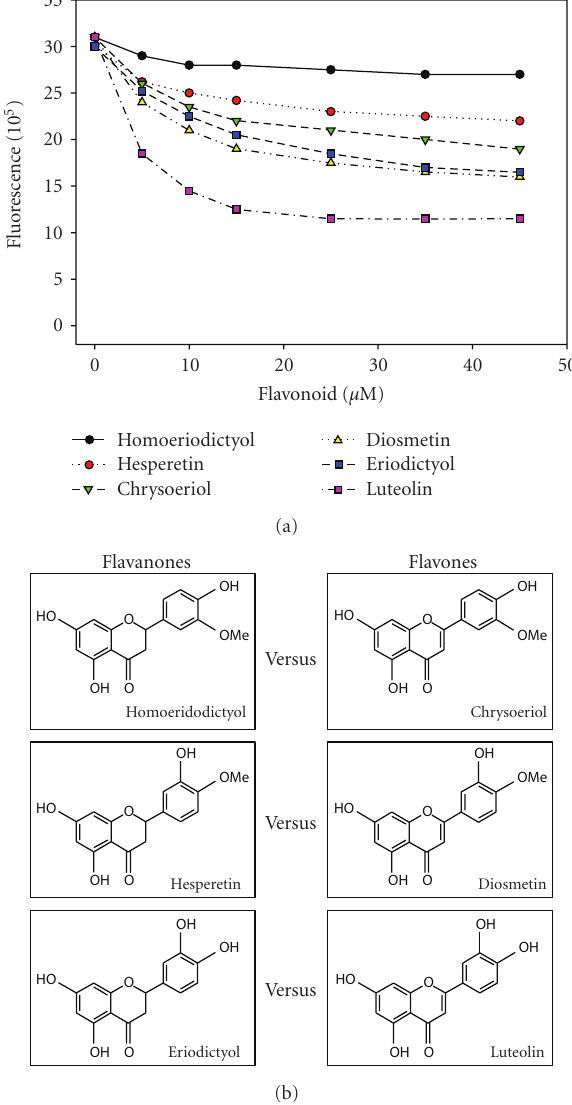
Figure 4: Titration of existing fibril-ThT complex by flavonoids. Structures of the flavonoids are listed on the right side. ThT concentration: 10 μ M. Cuvette volume: 1 mL. With excitation at 450 nm, fluorescence emission at 482 nm was measured upon the addition of